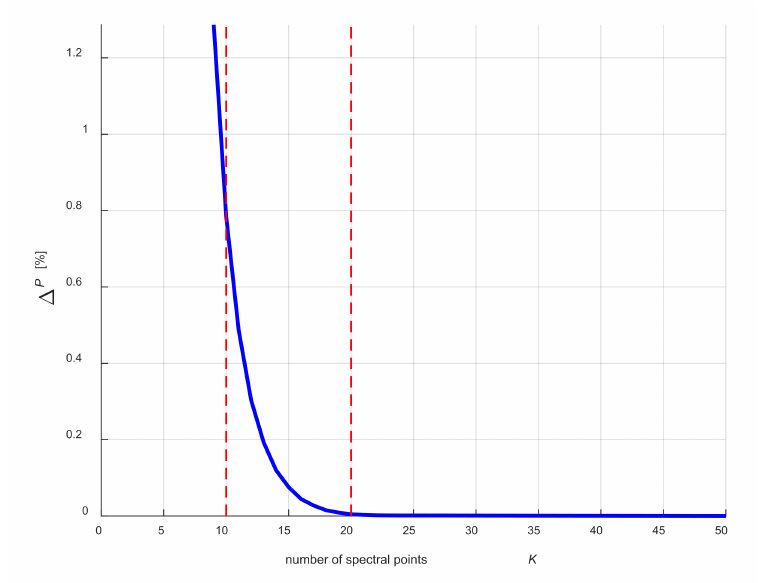
Figure 6. Change in the signal energy depending on number K of the assumed spectral points.